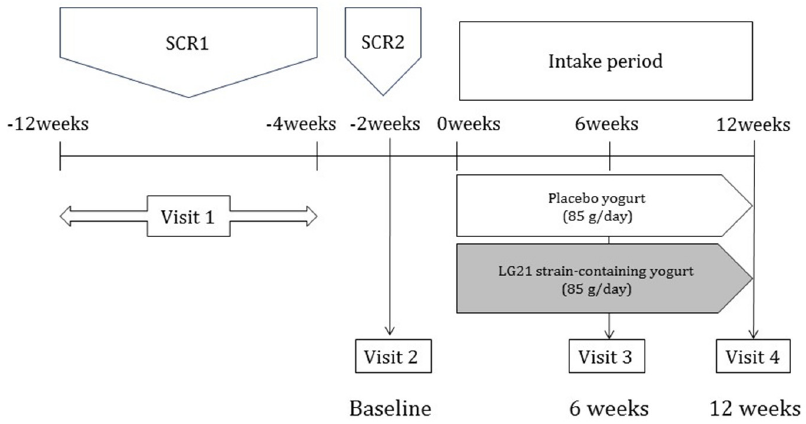
Figure 1. Study design and schedule: The study design and schedule are shown in Figure 1. SCR, screening. SCR,